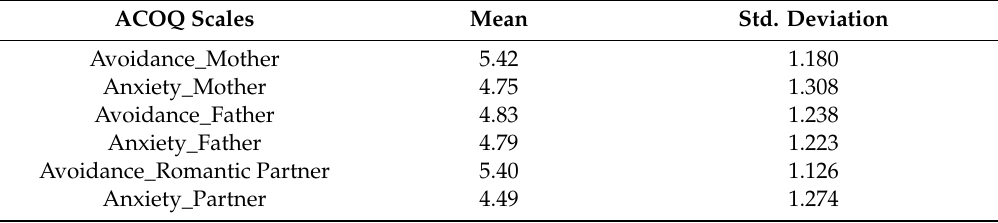
Table 1. Descriptive statistics for attachment security to parents and to the romantic partner *.